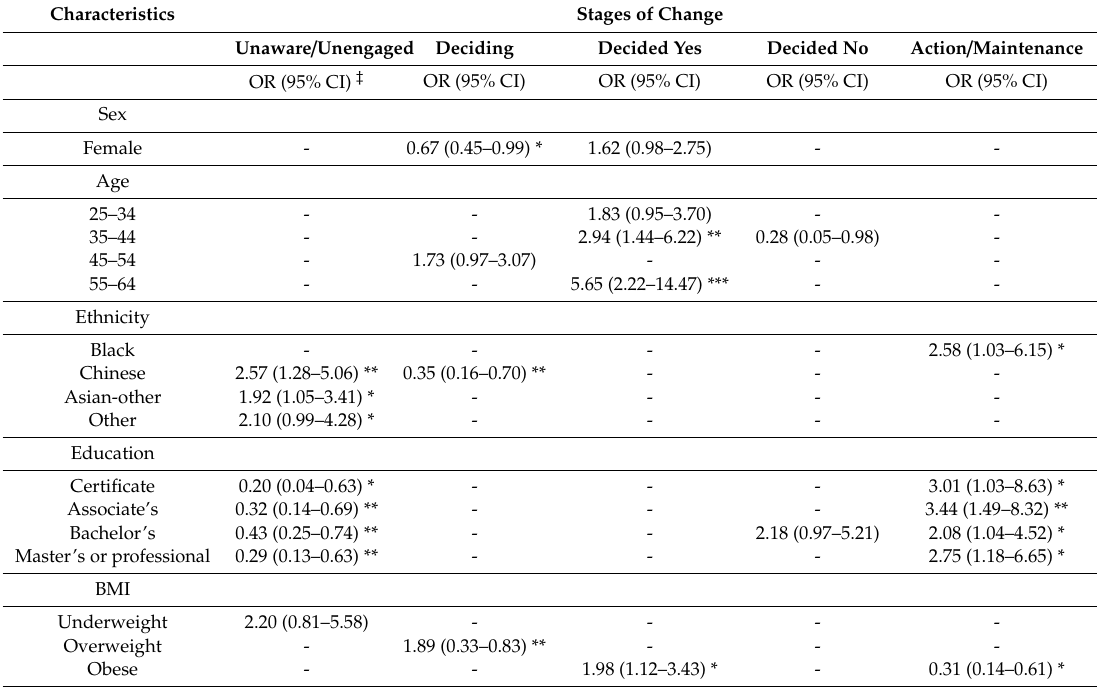
Table 6. Backward stepwise logistic regression of stage of change by demographic factors in the CA group.